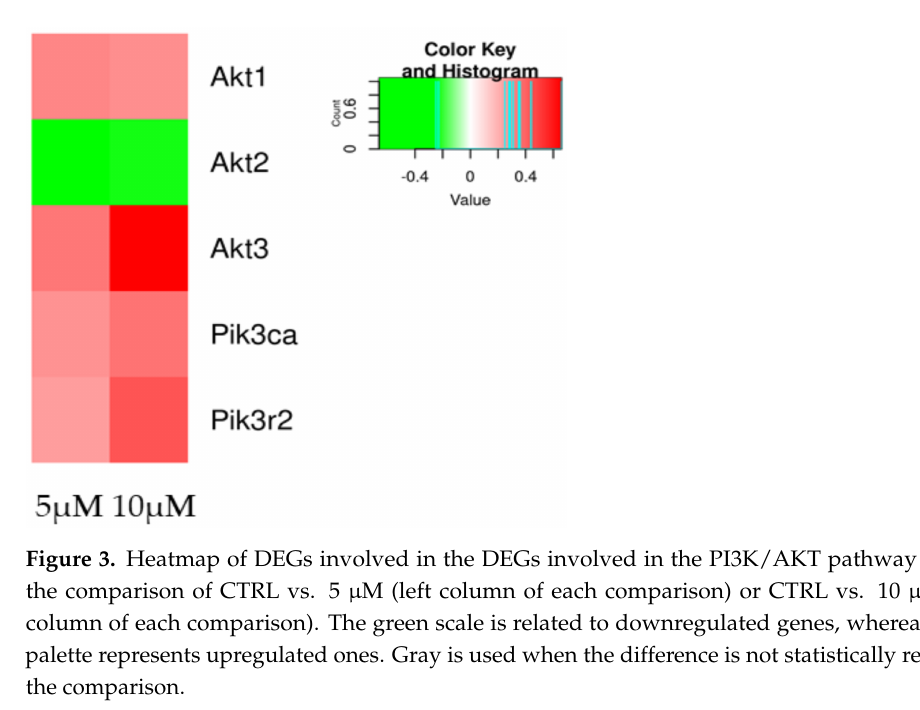
Table 6. DEGs of the Wnt pathway involved in the activation of β -catenin. Genes